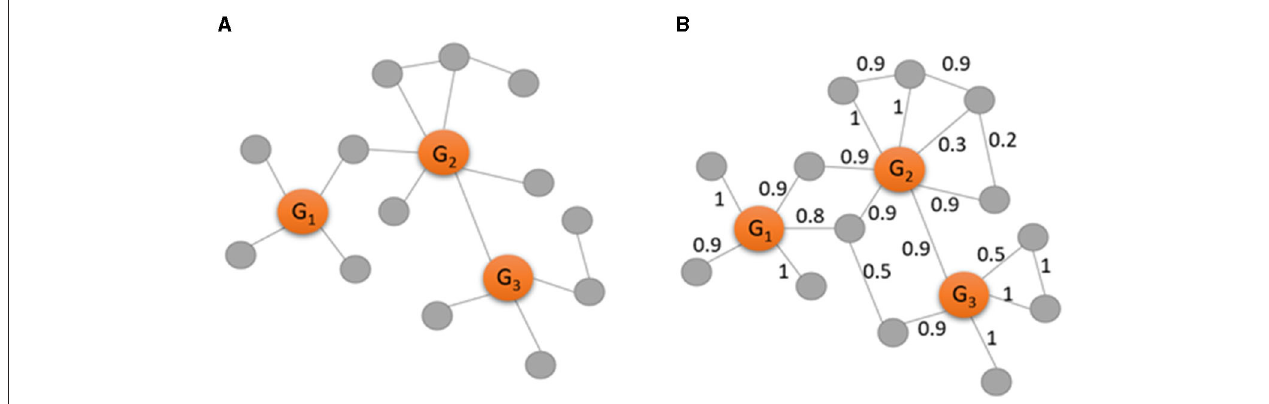
FIGURE 2 | Examples of a binary gene co-expression network (A) and a weighted gene co-expression network (B) consisting of three observed genes (in orange) and 13 genes (in gray). The edges in the network (A) are recognized by calculating and selecting gene pairs with highly correlated ( r ≥ 0.9), while the edges in the network (B) are weighted by the absolute values of the